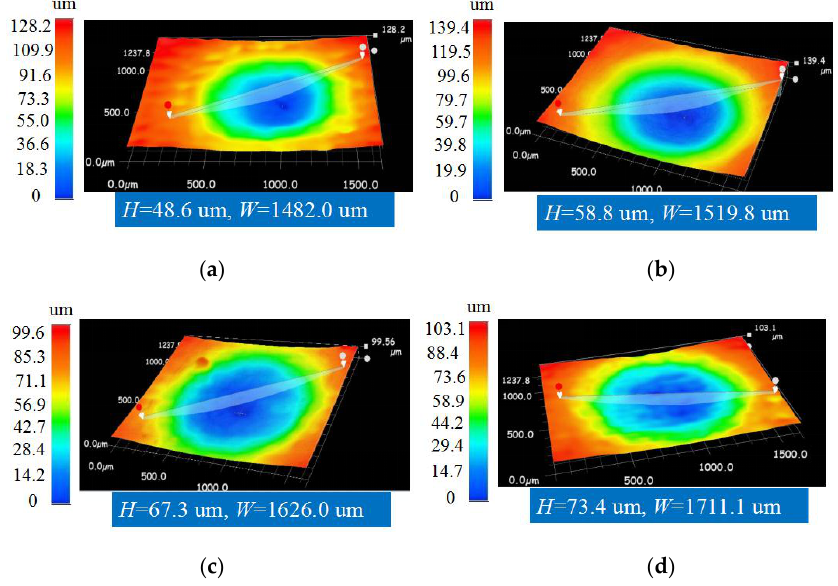
Figure 3. Three-dimensional morphologies of LP-induced dent at different temperatures: ( a ) LP at 25 ◦ C; ( b ) WLP at 100 ◦ C; ( c ) WLP at 130 ◦ C; ( d ) WLP at 160 ◦